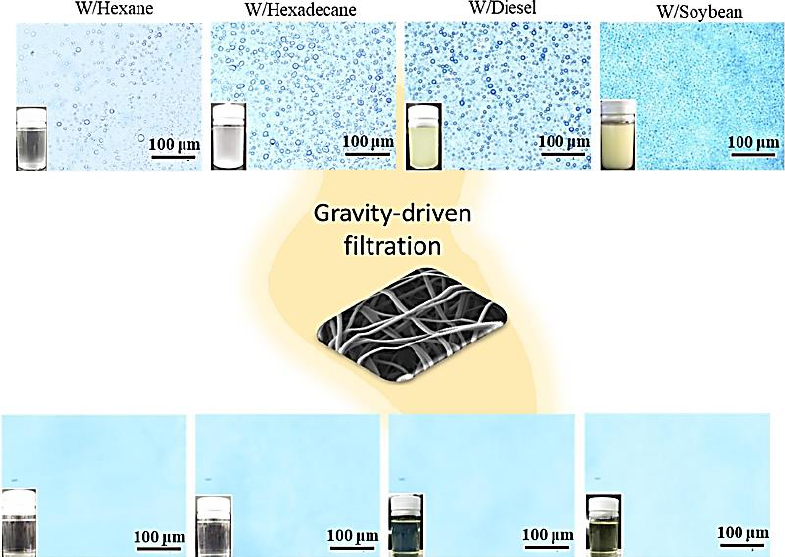
Figure 7. Optical micrographs of the feed emulsions ( top part ) and permeates ( bottom part ) using PMMA/60PDMS nanofibrous membrane under the sole influence of gravity [121]. Reprinted with permission from Ref. [121]. Copyright © 2021 Elsevier B.V. All rights reserved. Several membranes have been reported to separate the layered oil/water